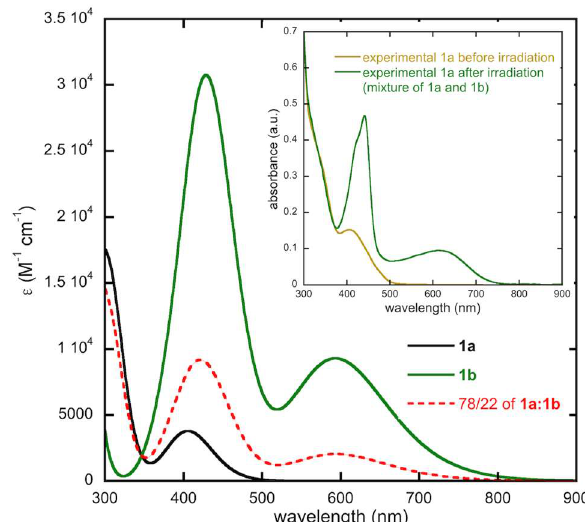
Figure 8. Computed spectrum of the photostationary state obtained upon irradiation of 1a in dichloromethane at TD-DFT level, along with the computed spectrum of 1a and pure 1b given as a reference. The photostationary state assumes a 78 / 22 ratio of 1a : 1b . The inset shows the obtained experimental data.